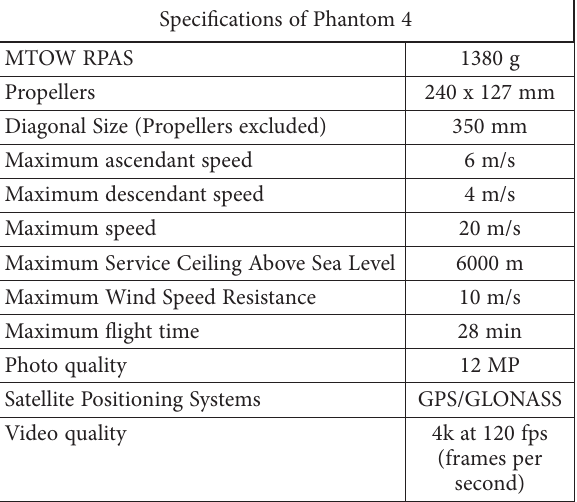
Table 1. Parameters of the RPAS Phantom 4 (DJI, 2016)